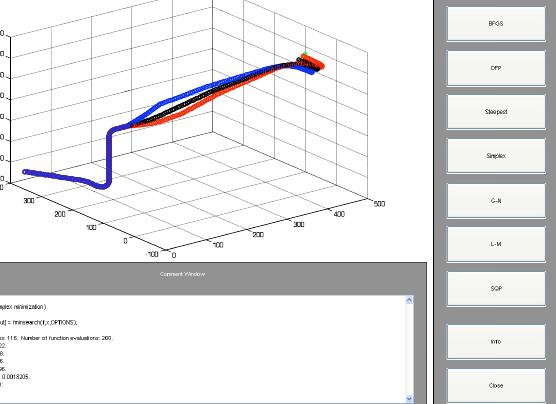
Fig. 7. Simplex module on the MATLAB application